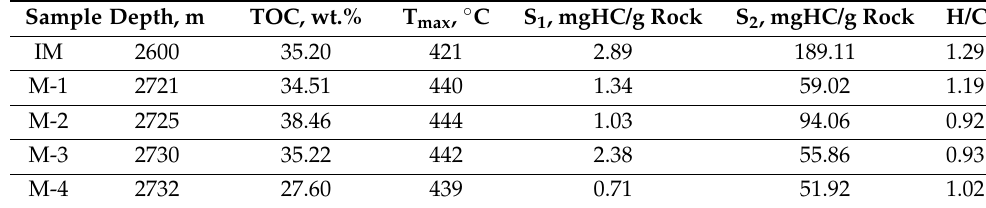
Table 1. General characteristics of kerogen samples.